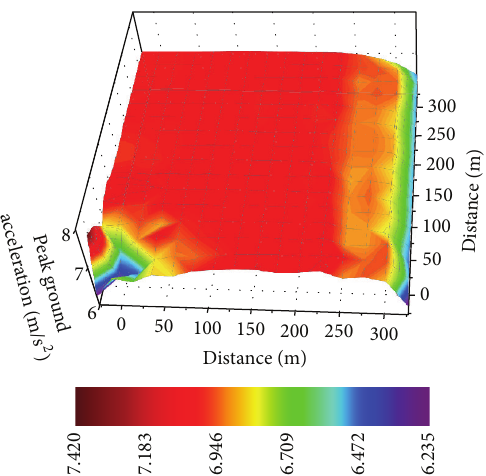
Figure 16: Peak ground acceleration distribution of URBAN2-2 (1/4 FE model, 𝐷 = 1.25 , El Centro, 𝑆𝑋